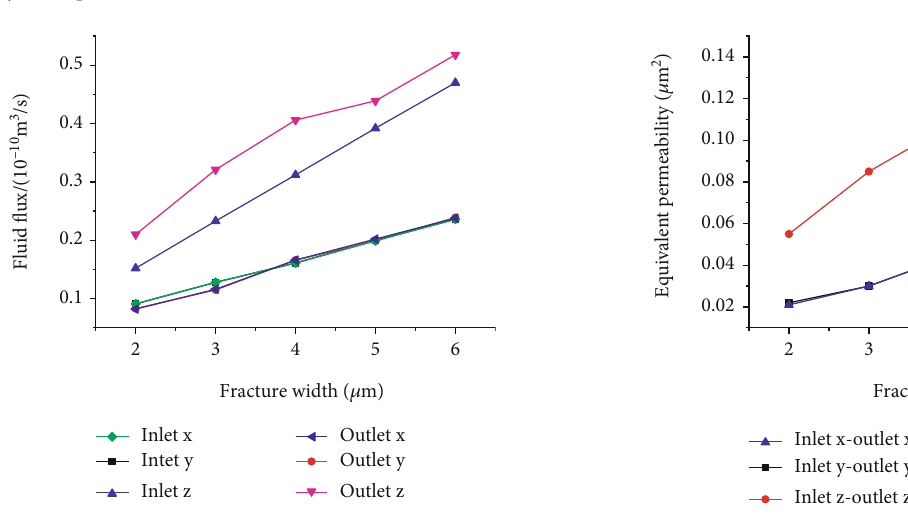
Figure 5: Pressure and velocity distribution of fracture fl uid with 4 μ m width. (a) Pressure on outlet. (b) Pressure on FSI. (c) Velocity w on MPF. (d) Velocity u on MPF. (e) Velocity v on MPF. (f) Total velocity on MPF. (g) Fluid velocity on bottom outlet. (h) Fluid velocity on top inlet.